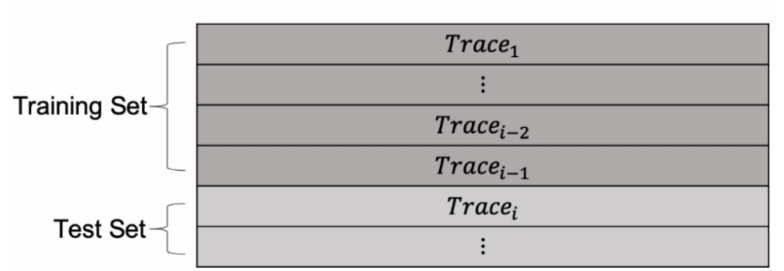
Figure 10. Training set and test